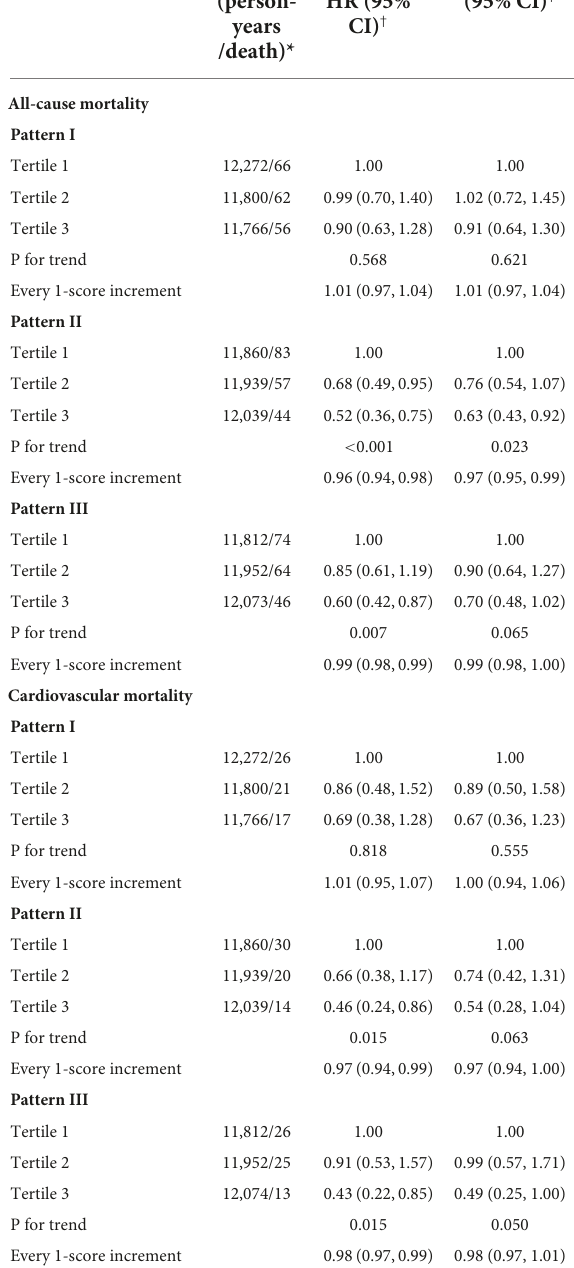
TABLE 4 Associations of healthy lifestyle index with mortality. TABLE 5 The association of lifestyle patterns with mortality.